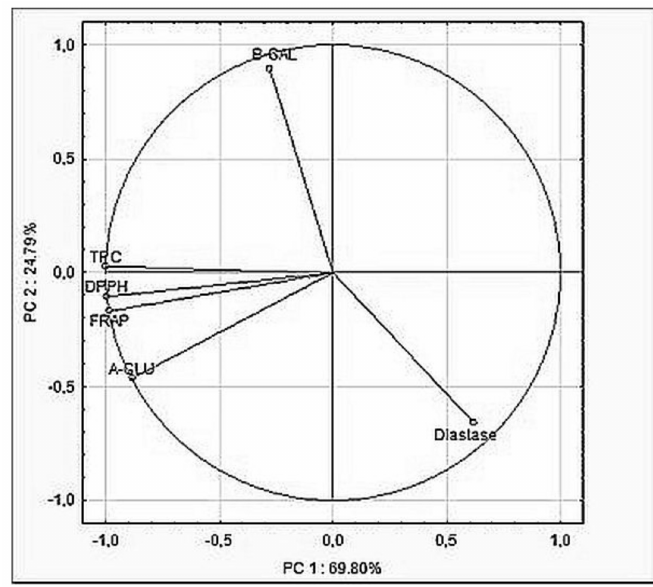
Figure 1. Principal component analysis (PCA)—biplot of scores and loadings of data obtained from antioxidant and enzymatic activity tested for creamed enriched honeys, as well as distribution of